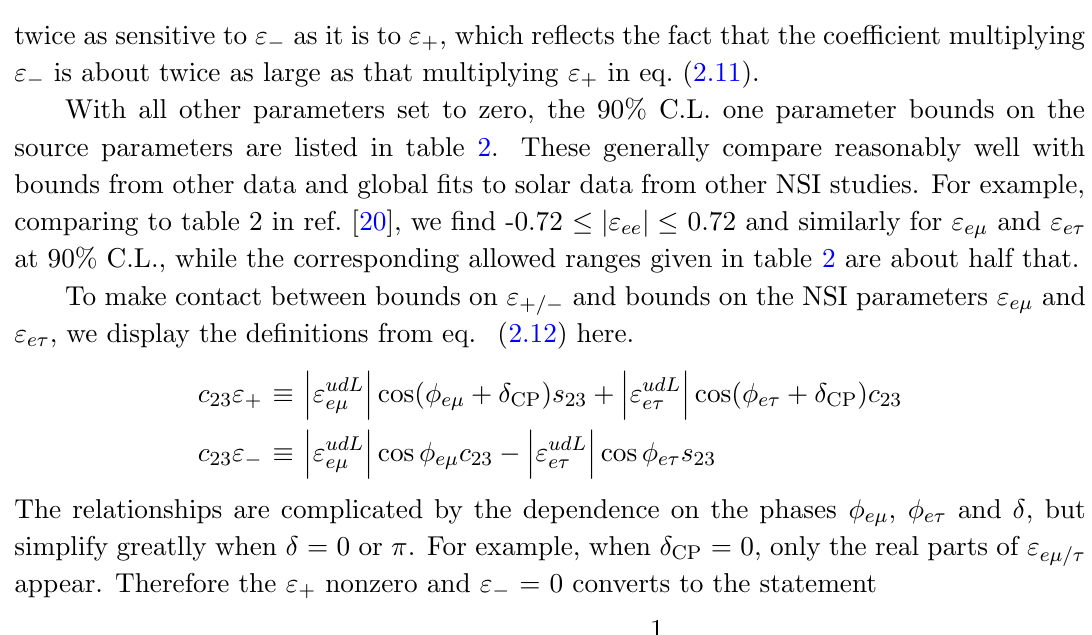
Table 2 . 1-parameter source NSI parameter best-(cid:12)t values and their corresponding 90% C.L.